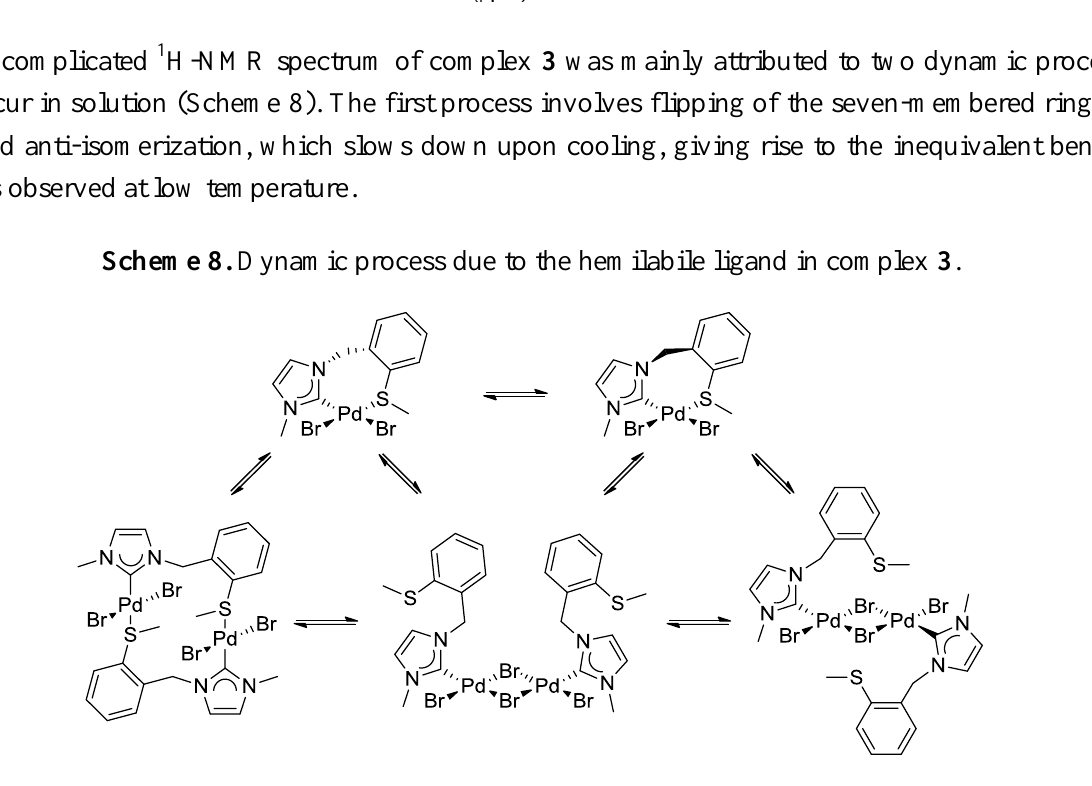
Figure 4. 1 H -NMR spectrum of 3 (300 MHz, CDCl